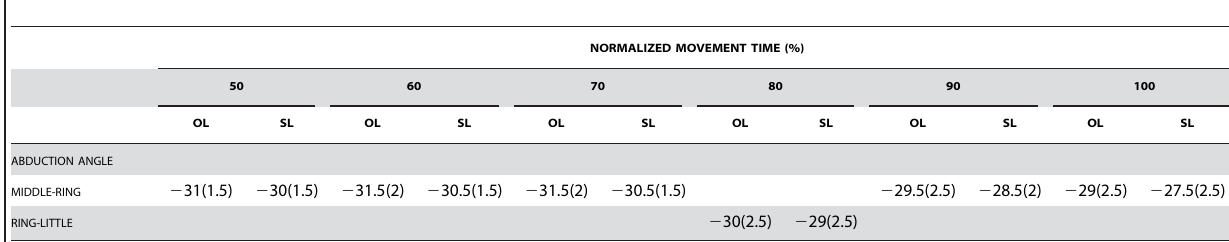
Table 2. Average fingers’ abduction angles at different epochs of the normalized movement time.